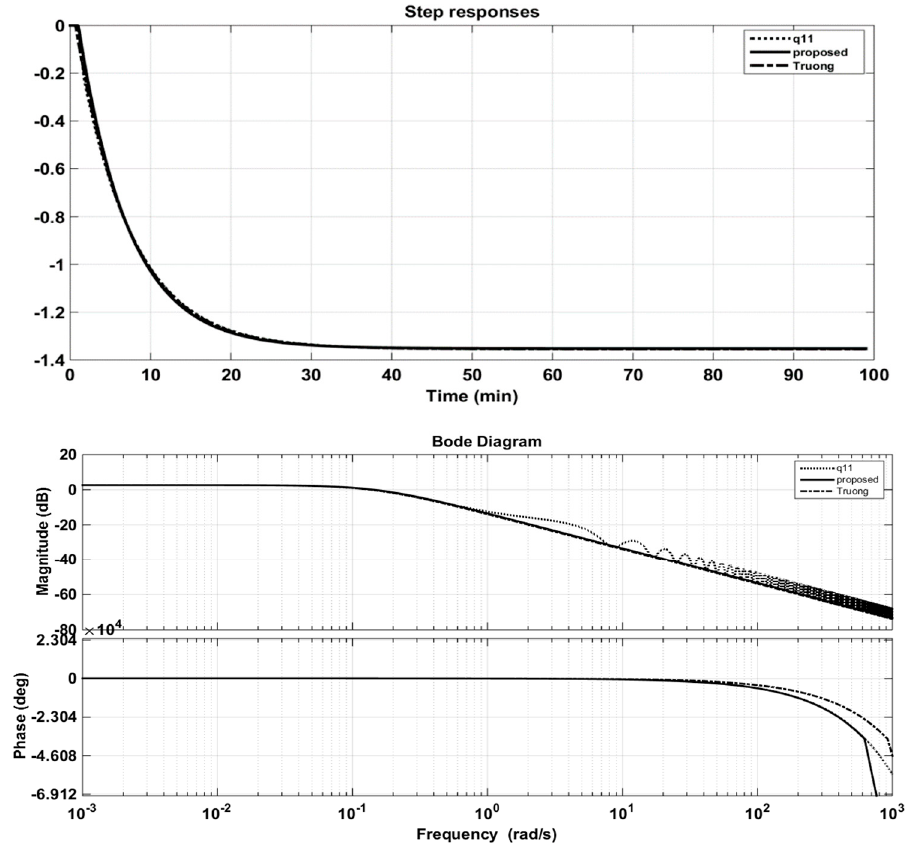
Figure 13. Step and Bode responses of original q 11 and its approximations (Vinante and Luyben (VL) column).